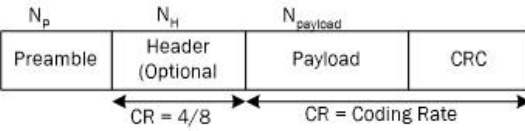
Figure 1. Long-range (LoRa) packet